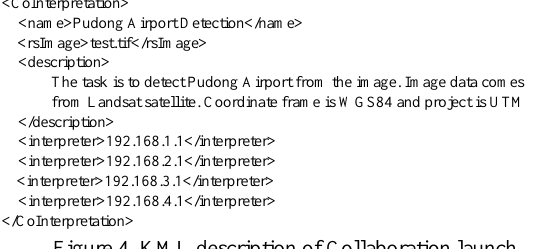
Figure 4. KML description of Collaboration